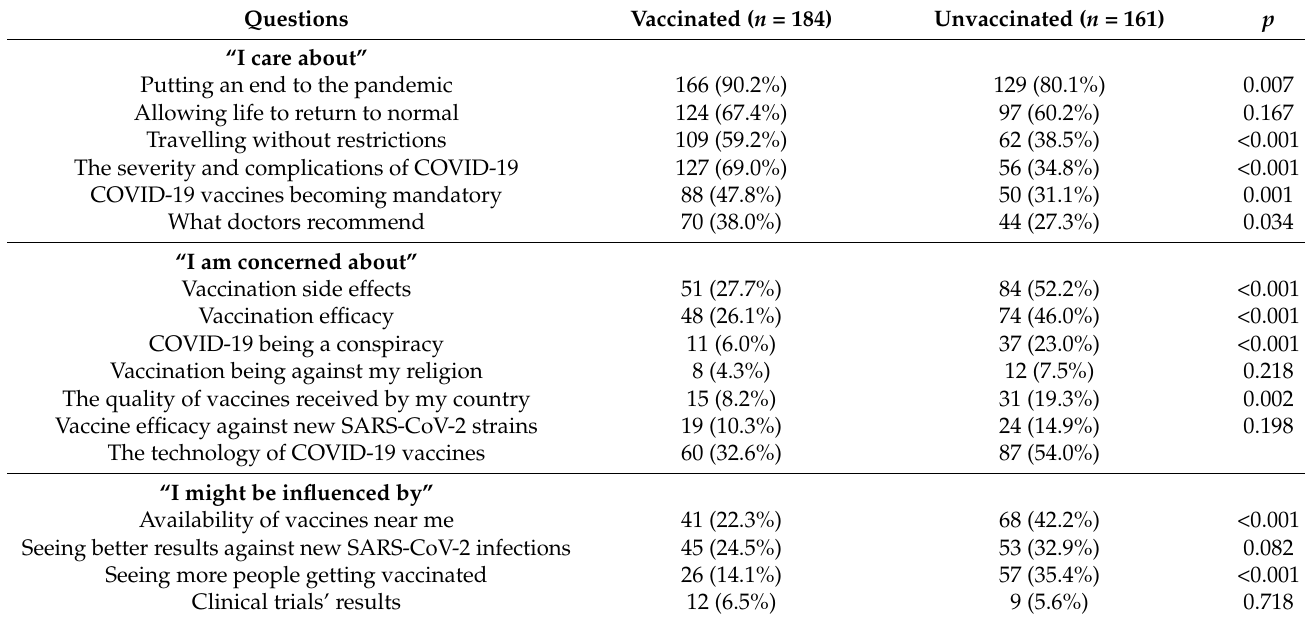
Table 5. Assessment of reasons for COVID-19 vaccine acceptance.